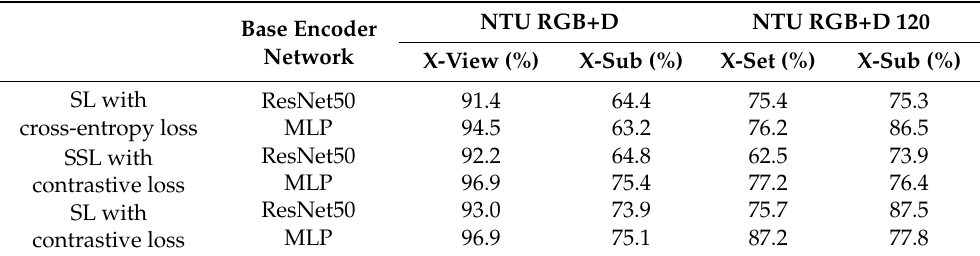
Table 4. Top 1 accuracy comparison with cross-entropy